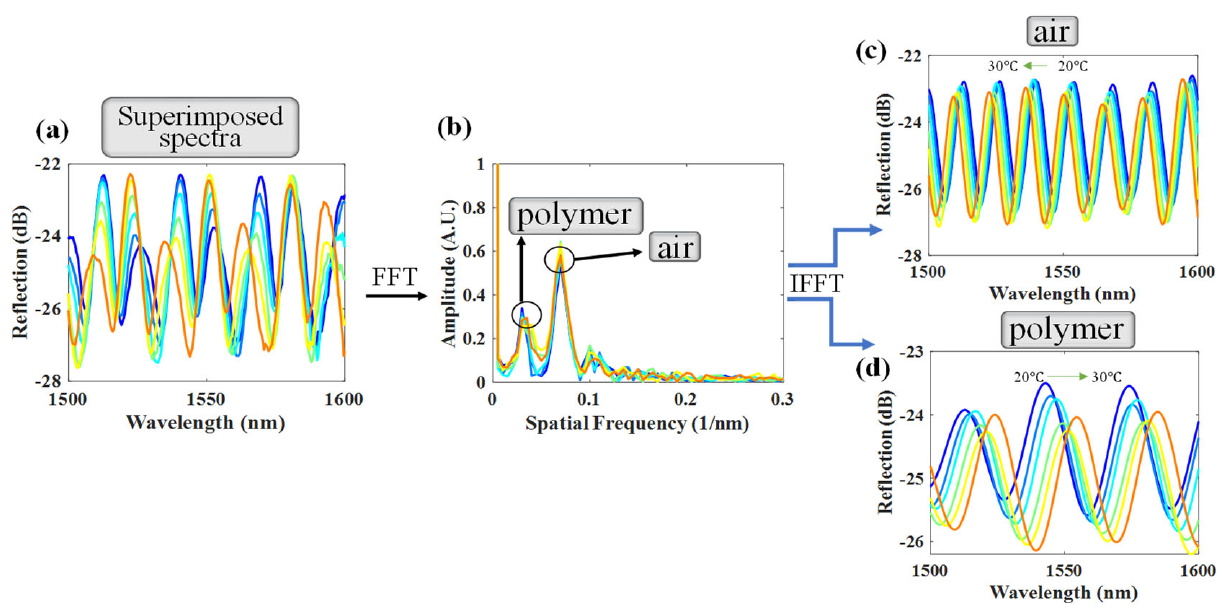
Figure 4. ( a ) Optical response of the superimposed interferences with variation in T; ( b ) superimposed spectra processed by FFT; separated reflection spectra of the ( c ) air cavity and ( d ) polymer cavity.